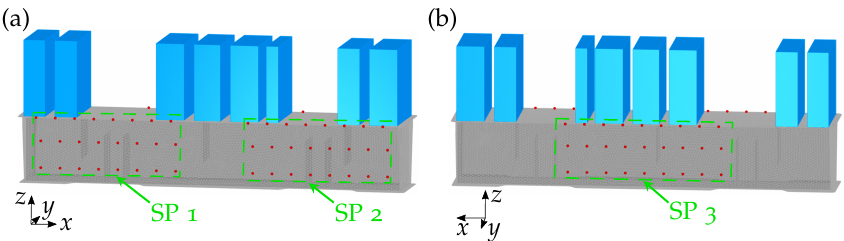
Figure 11. All positions of the three support points (SP, small red dots) that were considered in the parametric study are displayed exemplarily for the PETRA III girder in a 3D front view ( a ) and back view ( b ). The girder (grey) is slighly transparent making the inner ribs visible. All positions that the support points 1, 2, and 3 are assigned to during the parametric study are framed in light green. The magnets supported by the girder are shown in